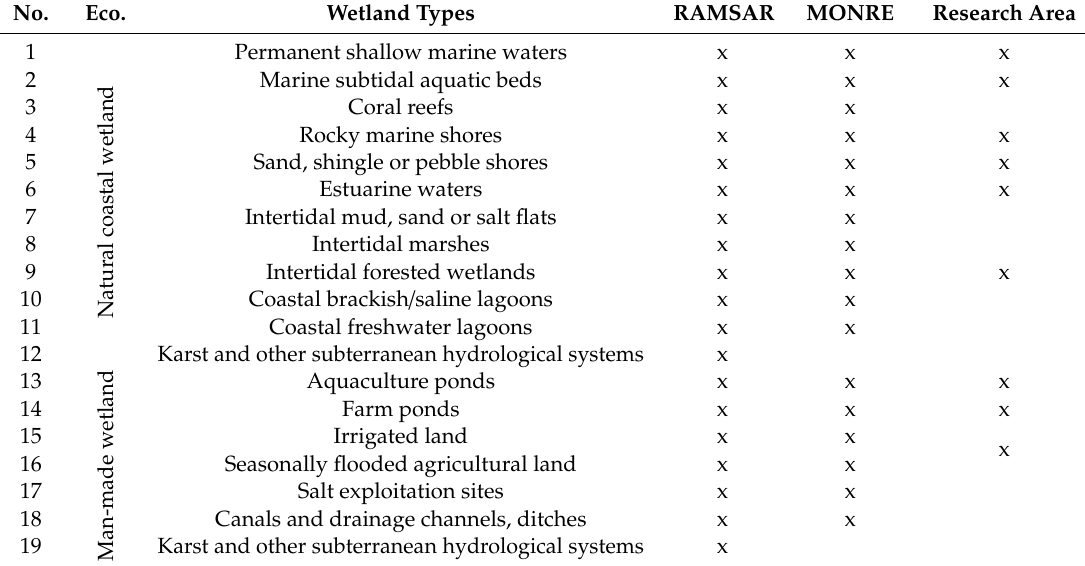
Table 1. Wetland classification based on RAMSAR, MONRE, and the selection of the wetland types for the research